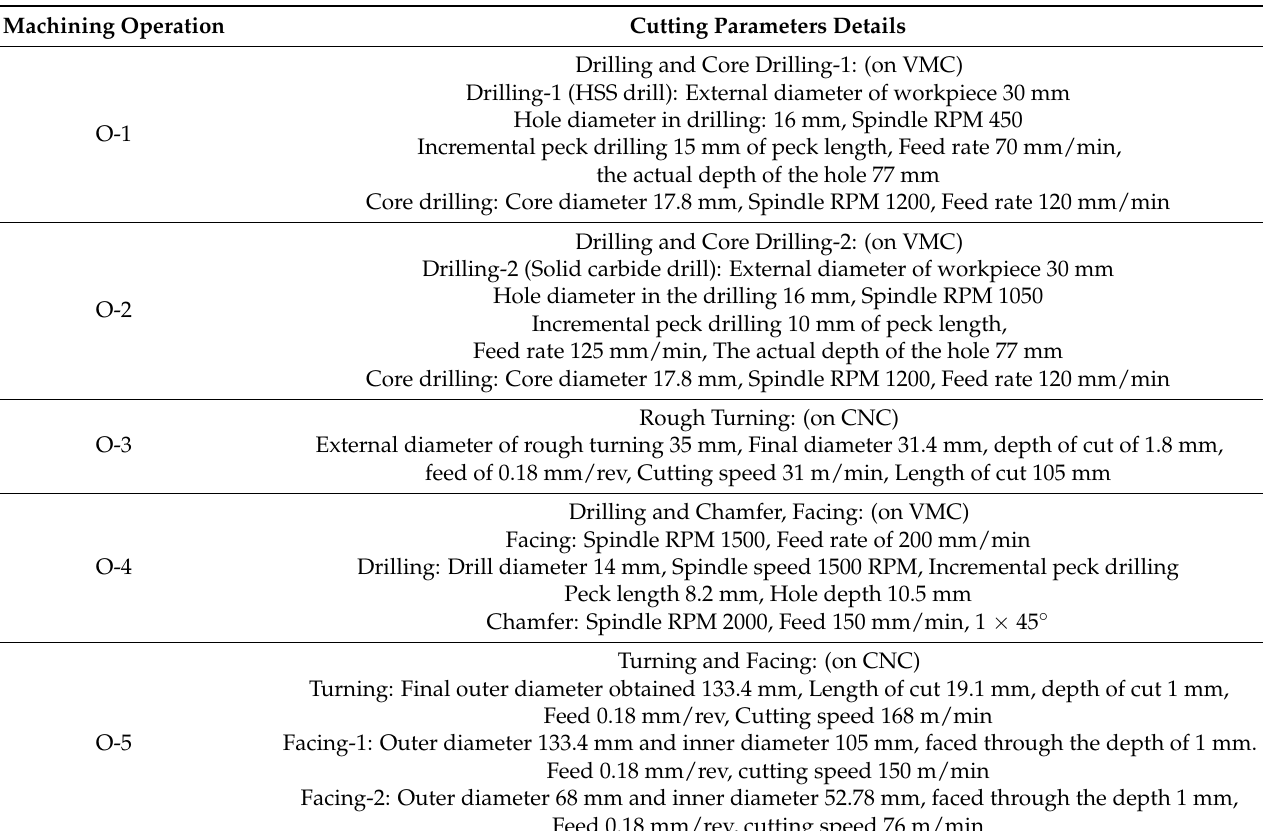
Table 3. Cutting parameters for machining